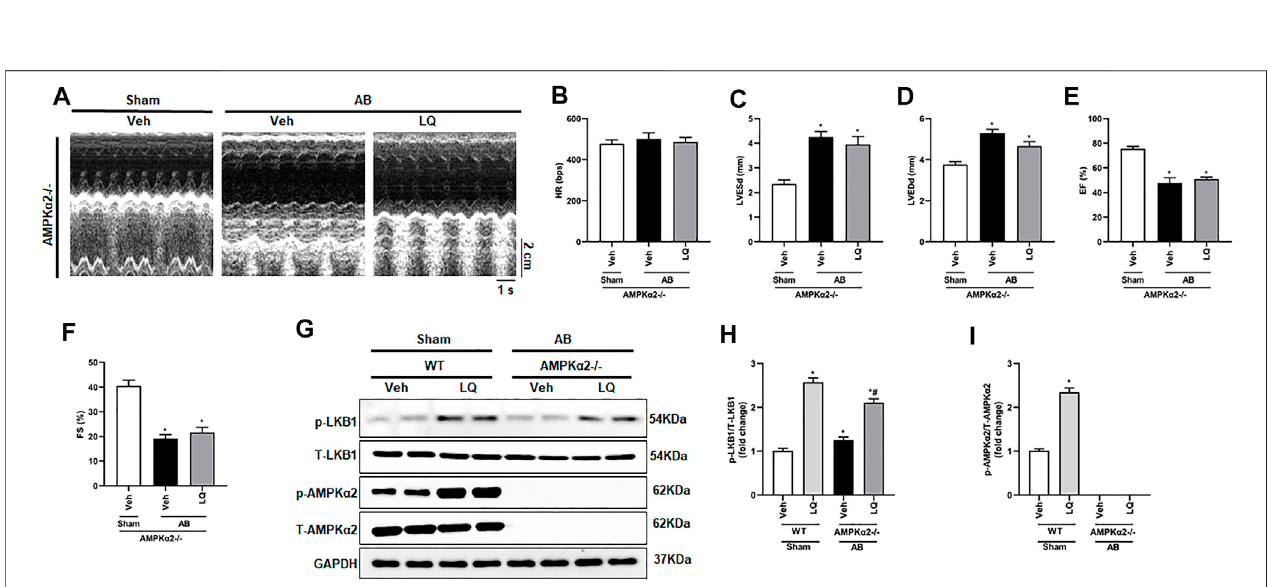
FIGURE 6 | Liquiritin does not prevent hypertrophy-related cardiac dysfunction in AMPK α 2 knockout mice. (A) Representative echocardiographic images. (B) Heartrate (HR). (C) Left-ventricularend-systolic diameter(LVESd). (D) Leftventricularend-diastolic diameter(LVEDd). (E) Ejectionfraction (EF). (F) Fractionalshortening (FS); (Sham, n =6;AB, n =8). (G) Representativeimmunoblotsdepictingcardiac expressionofAMPK α 2andLKB1inAMPK α 2 − / − mice.Relativeexpression of (H) LKB1 and (I) AMPK α 2 based on western blot results ( n = 6); GAPDH was used for normalization. Data are presented as the mean ± SEM. One-way ANOVA was performed to examine statistical differences among different groups. * p < 0.05 vs. Sham + Veh; # p < 0.05 vs. AB + Veh.